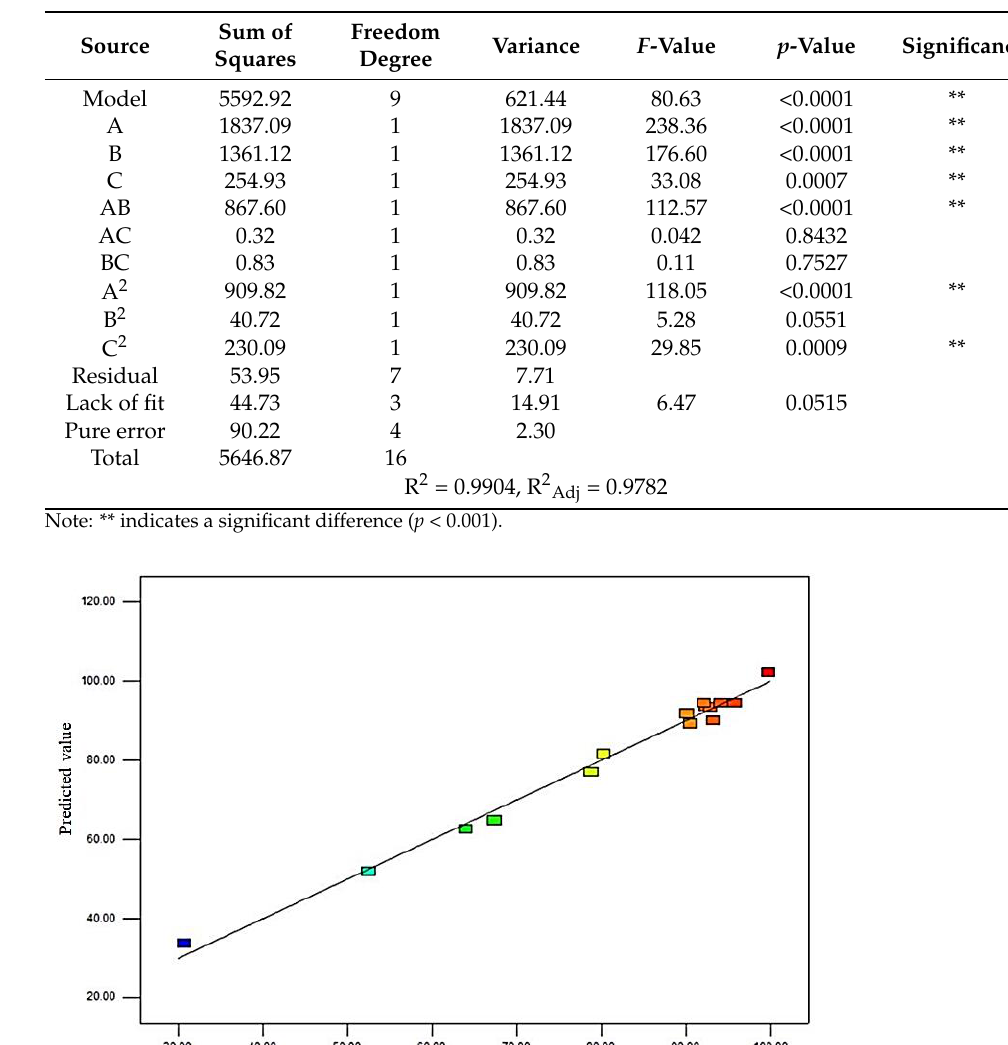
Figure 4. Response surface plots showing the interactive effects of various factors on the degrada- tion rate of AFB 1. Note: Figure ( a ) represents the effect of the interaction of the temperature and pH on the AFB 1 degradation rate; Figure ( b ) represents the effect of the interaction of the temperature and degradation time on the AFB 1 degradation rate; and Figure ( c ) represents the effect of the inter- action of the degradation time and pH on the AFB 1 degradation rate. Colors ranging from blue to red indicates low to high degradation rates. The lines in the y-coordinate have no real mean- ing.